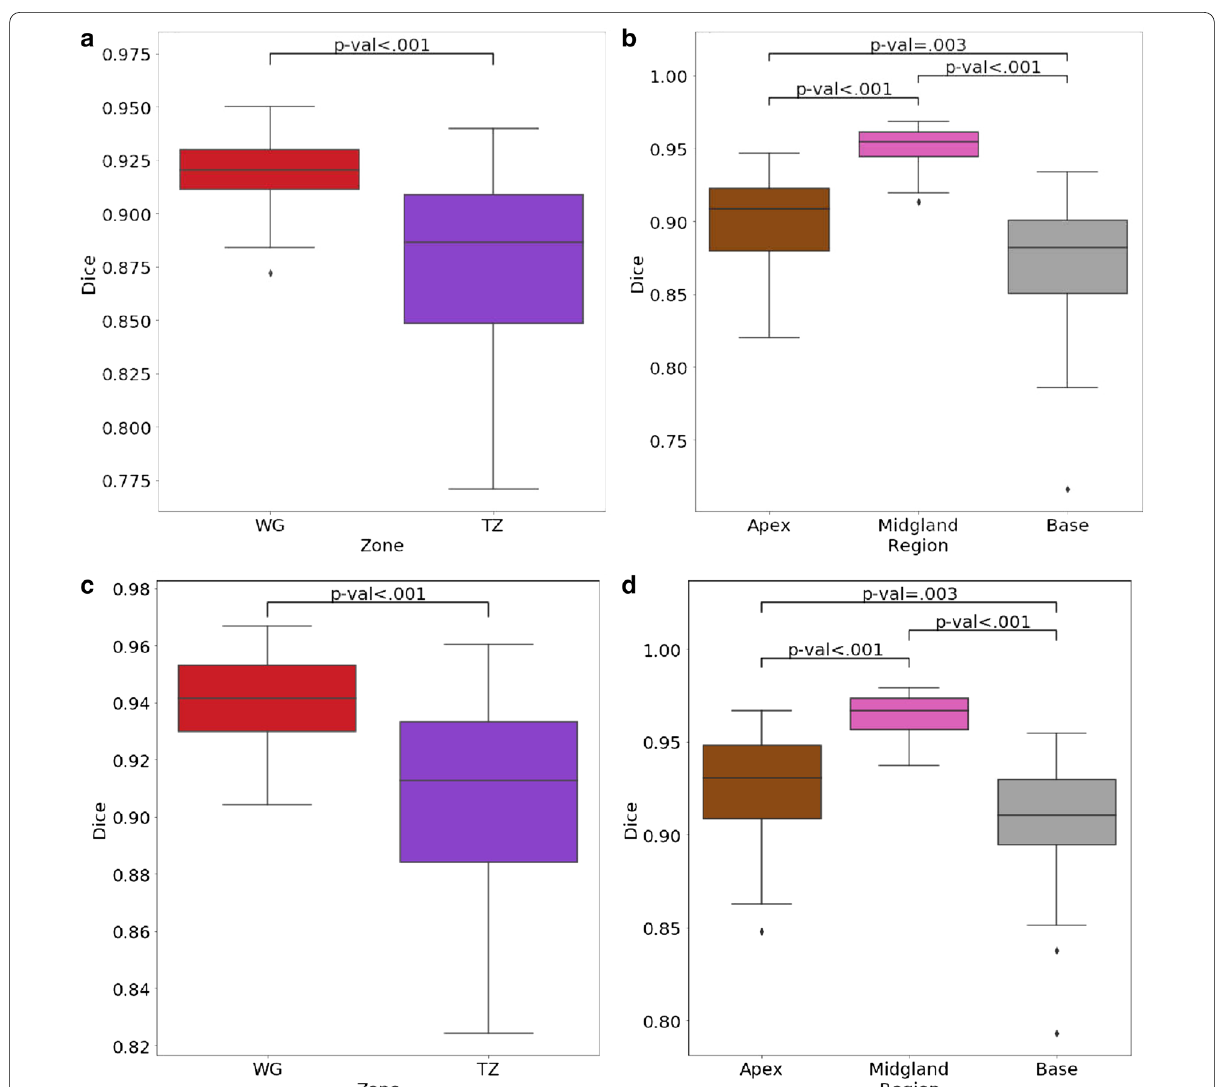
Fig. 3 Comparison of DSC for segmentations of WG and TZ ( a , c ), and for WG segmentation when the prostate is divided along the cranio‑caudal axis in the base/mid‑gland/apex ( b , d ), using a pairwise comparison ( a , b ) and a consensus comparison ( c , d